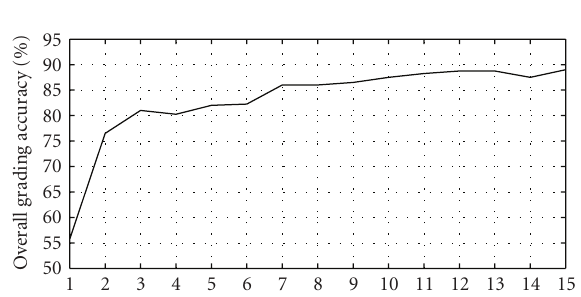
Figure 7: Overall grading accuracy with respect to the number of most discriminative features selected in the grading. Highest overall grading accuracy is achieved when the whole feature set is